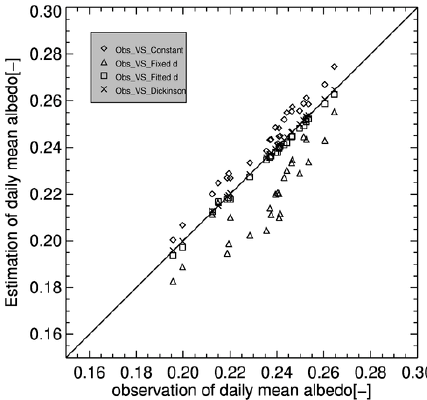
Figure 4. The comparisons between observed daily mean clear-sky albedo and estimated daily mean albedo under the four assumptions (constant albedo, fixed d, fitted d, and Dickinson model.).